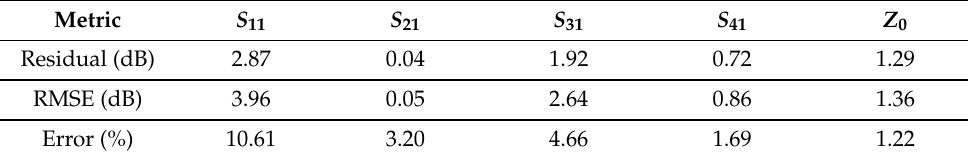
Table 5. ANN model prediction performance in stripline